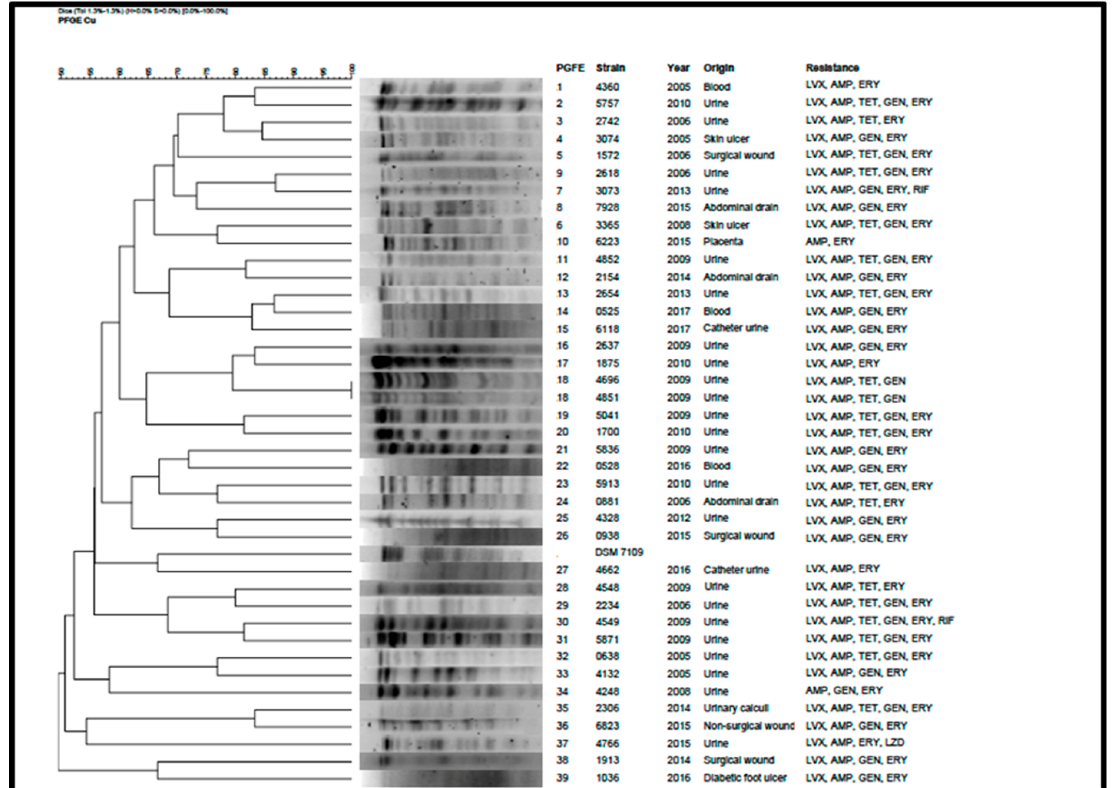
Figure 4. PFGE patterns, dendrogram, sample origin, and resistance profiles of the 40 C. urealyticum and the reference strain DSM 7109. LVX: levofloxacin; AMP: ampicillin; TET: tetracycline; GEN: gentamicin; ERY: erythromycin; RIF: rifampicin; LZD: linezolid.